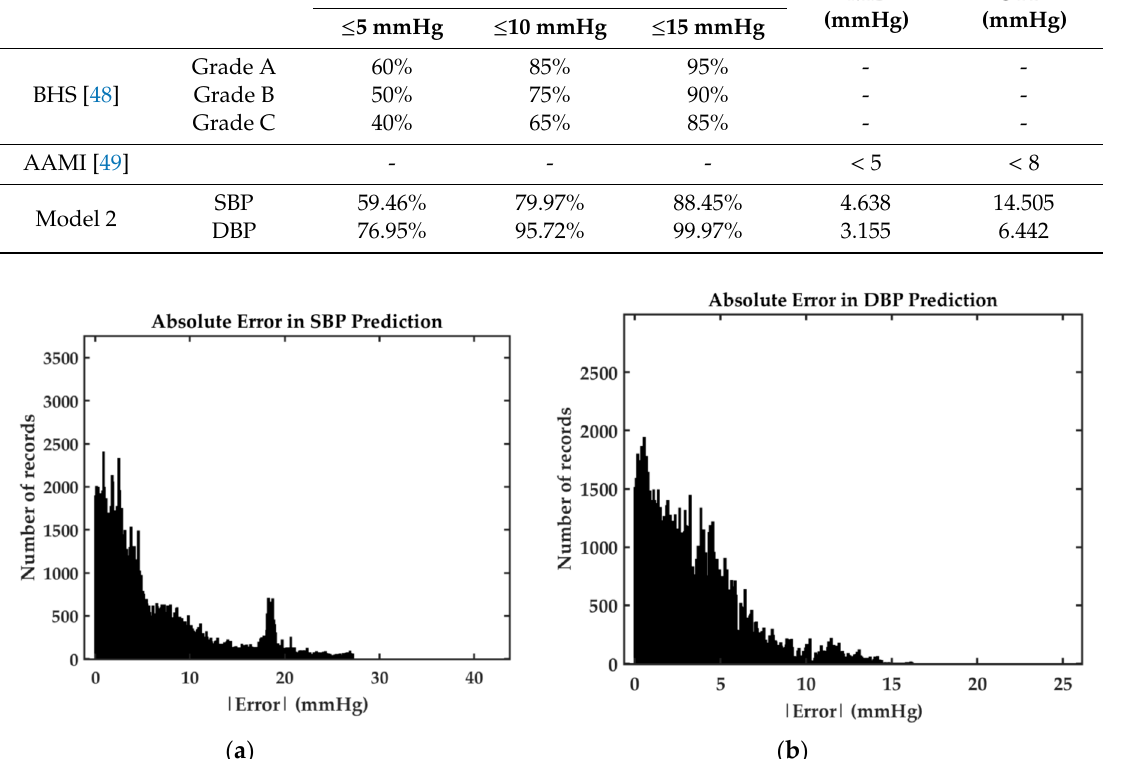
Figure 11. ( a ) SBP absolute error histogram from Model 2 ( b ) DBP absolute error histogram from Model 2.